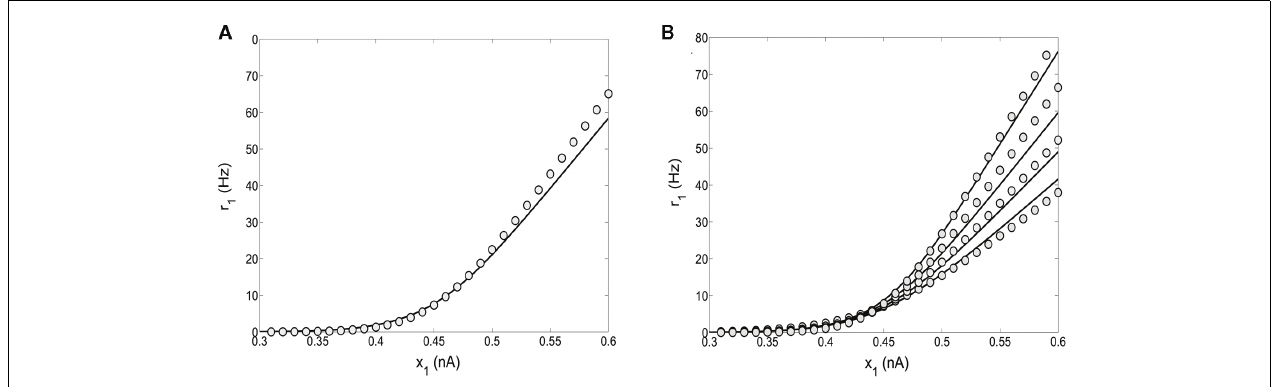
FIGURE 5 | (A) Input–output function of population 1: the line is numerical solution of Eq. 65 and the circles are fit of the effective transfer function Eq. 67. (B) Numerical solutions (lines) and fits (circles) as in 5A for different couplings through AMPA synapses: from right to left J A,11 = J A,22 = 0, 0.0005, 0.001,